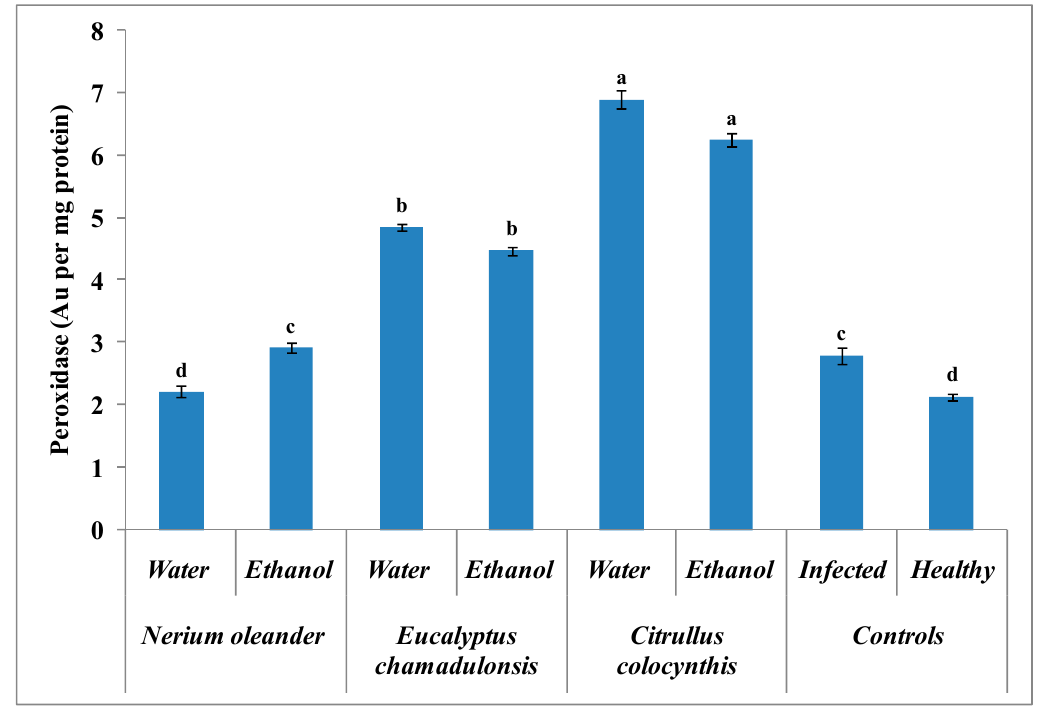
Figure 4. Effect of 15% concentrations of plant extracts of Nerium oleander, Eucalyptus chamadulonsis and Citrullus colocynthis on peroxidase activity as absorbance units (Au) per mg protein of ‘Super Marmande’ tomato after 7 days of treatment with the extracts and inoculated with Xanthomonas axonopodis pv. vesicatoria PHYXV3. Four replicates were used for each treatment. Columns with the same letters are not significantly different according to Fisher’s protected least significant difference at p ≤ 0.05.